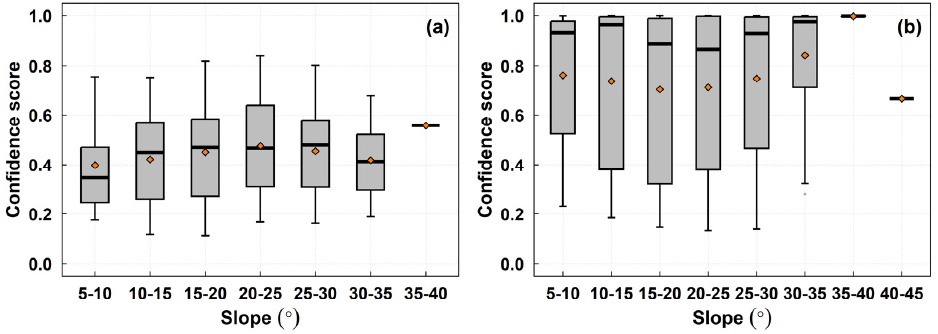
Figure 10. Confidence scores for different slopes using the transfer-trained DeepForest ( a ) and De- tectree2 ( b )